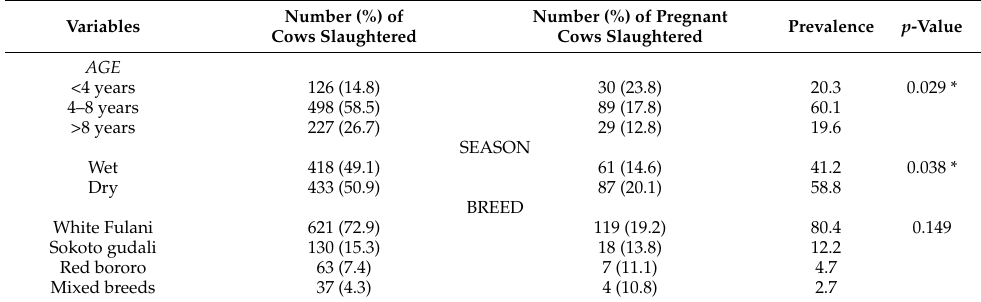
Table 3. Age, season and breed distribution of pregnant cows ( n = 148) slaughtered in South-East Nigeria. Variables